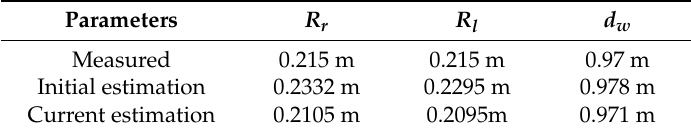
Table 2. Parameter estimation after 15